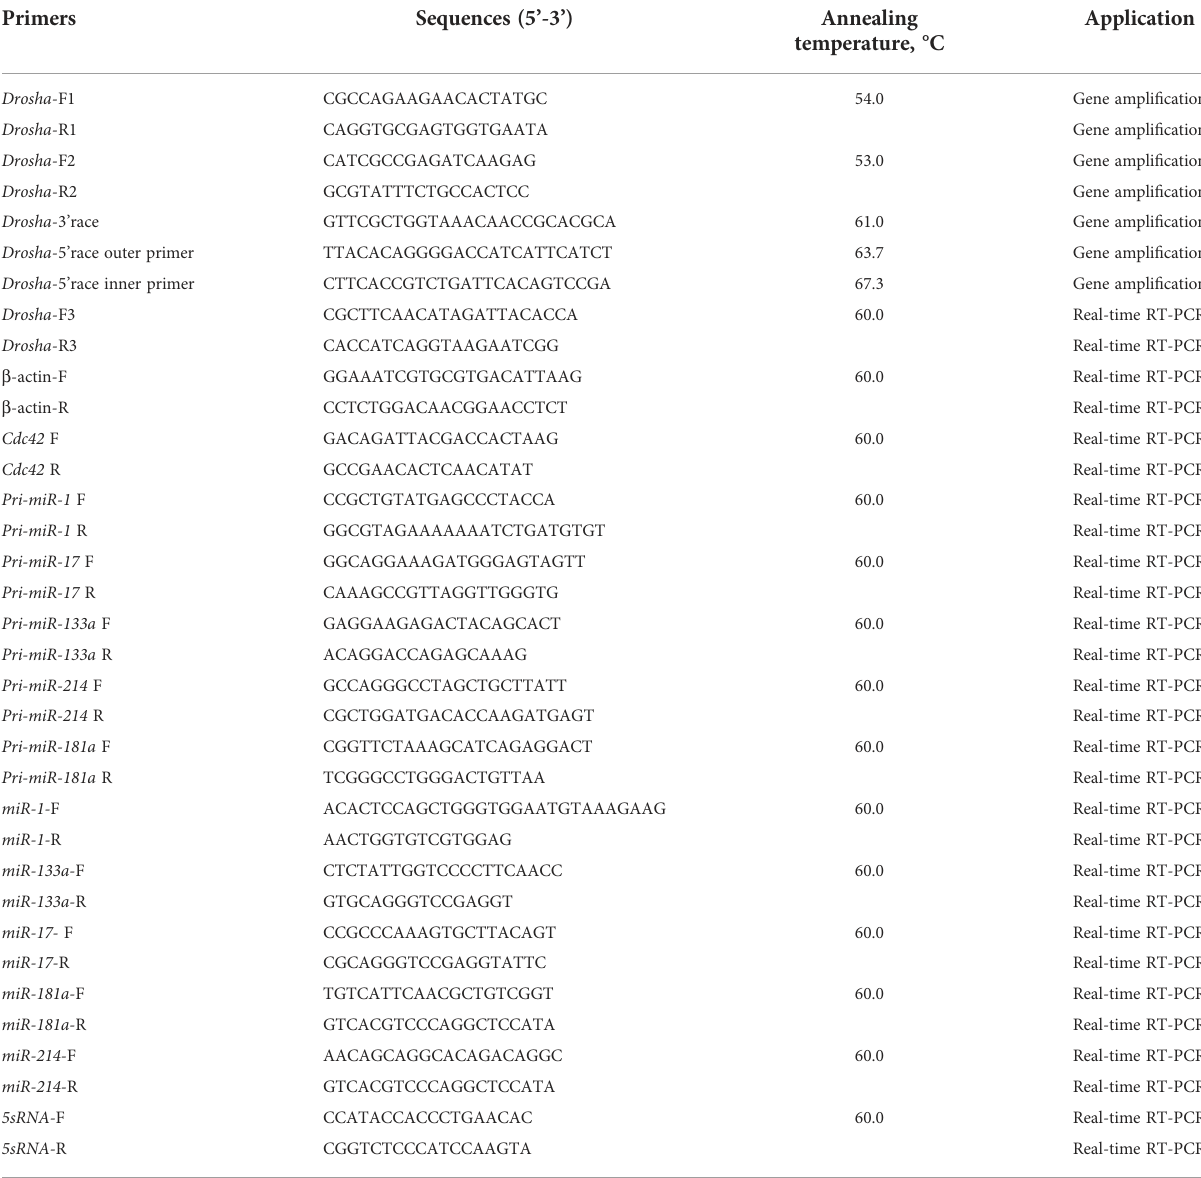
TABLE 1 The primer sequences for the PCR used in the present